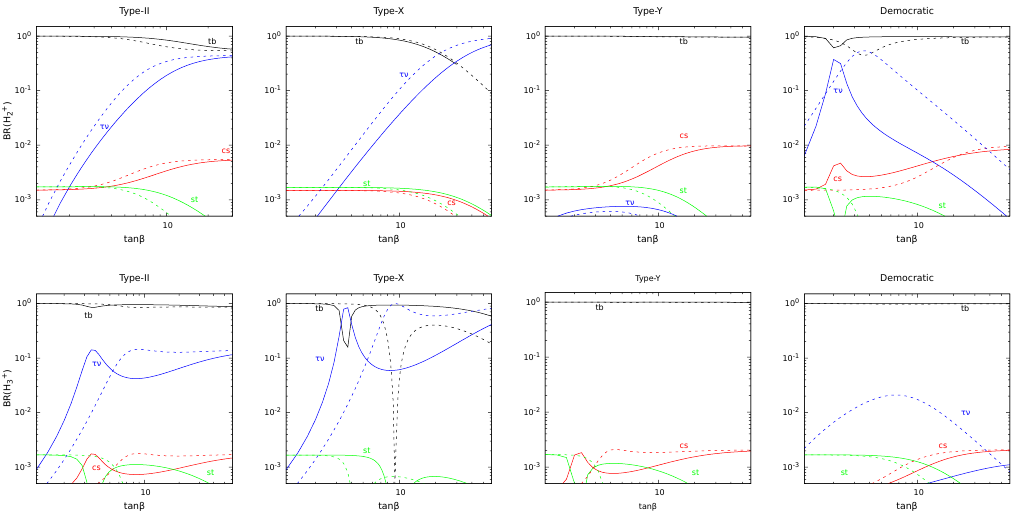
Figure 2 . As in figure 1 but for M